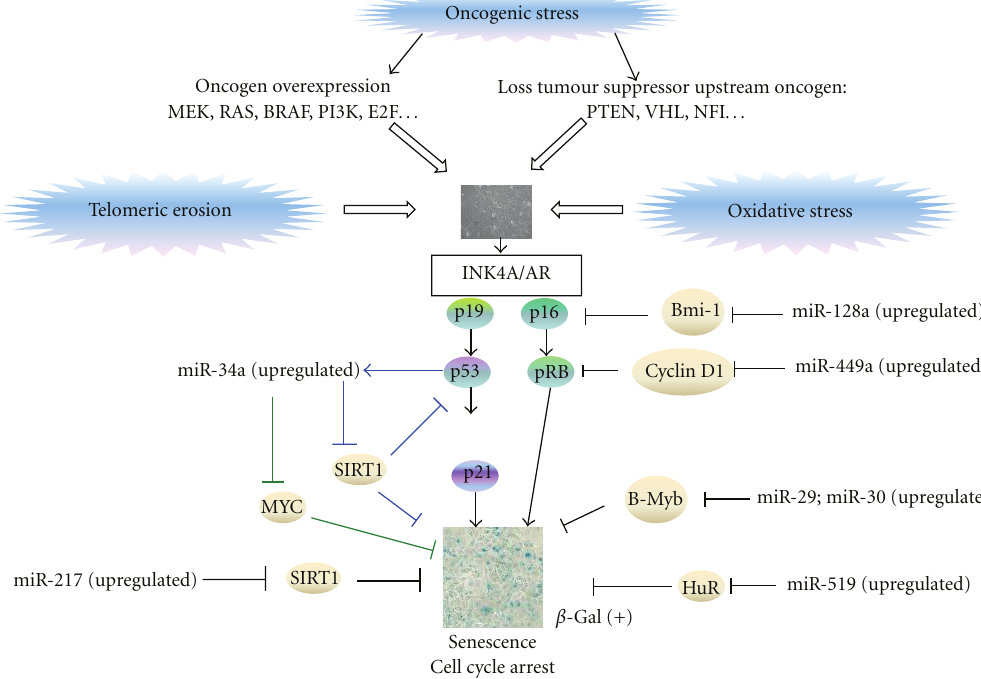
Figure 2: Role of miRNAs in senescence. Cellular senescence is triggered by several factors including telomeric erosion, oncogenic stress, oxidative stress, and miRNA modulation. The following miRNAs are key regulatory miRNAs modulating senescence: miR-128a, miR-449a, miR-29, miR-30, miR-519, miR-217, and miR-34a.